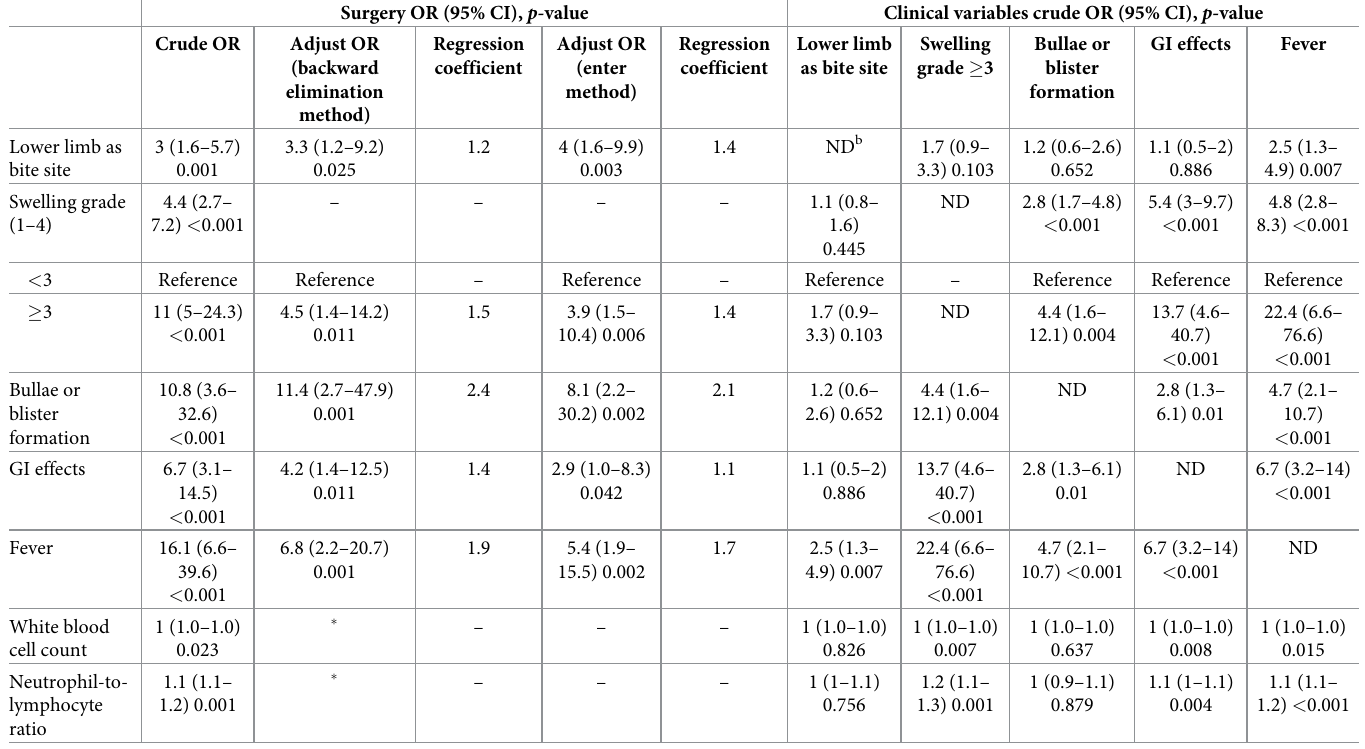
Table 5. Risk factors for surgery in logistic regression and the association between clinical